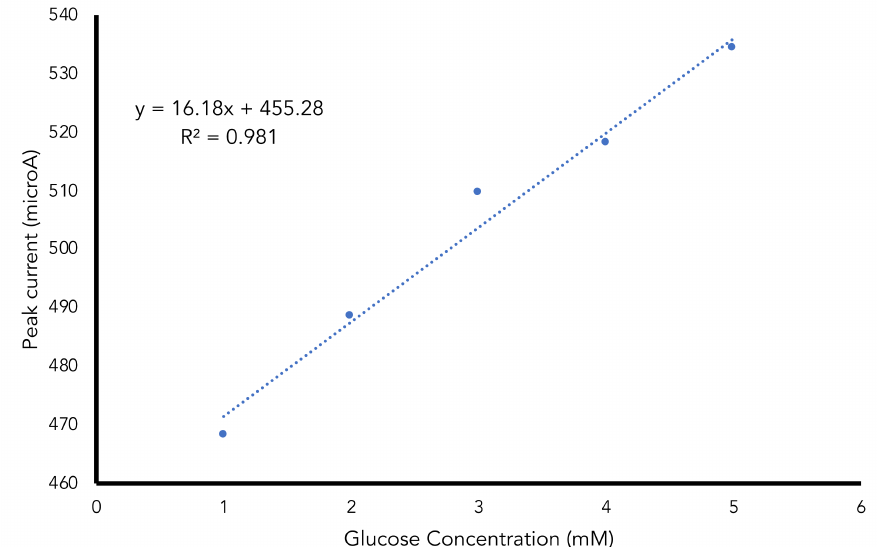
Figure 7. Glucose determination using fabricated alginate NiFe 2 O 4 nanoparticles cryogel